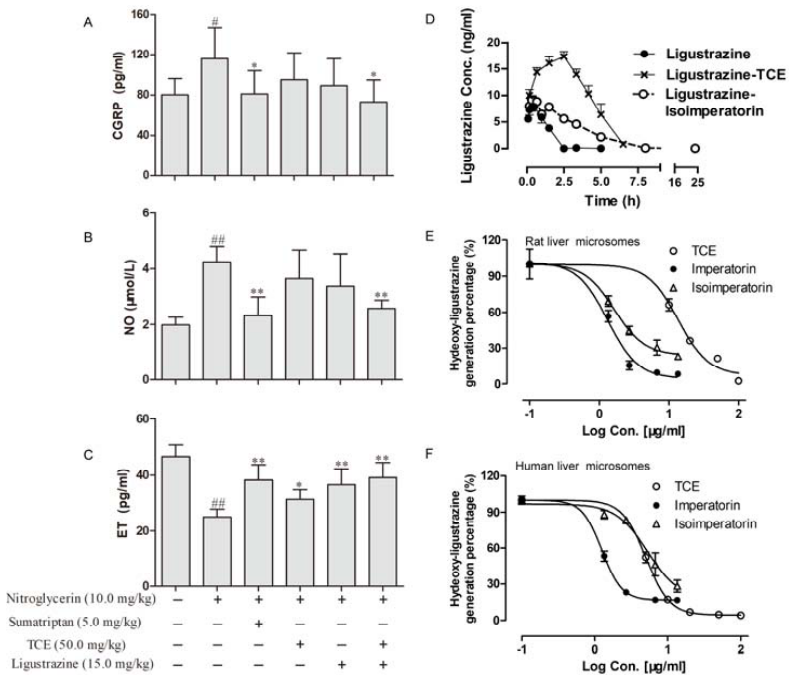
Figure 2. Pharmacodynamic and pharmacokinetic interaction between TCE and ligustrazine ( n = 6). ( A–C ) The plasma CGRP, serum NO and ET levels in rats with migraine (induced by subcutaneously